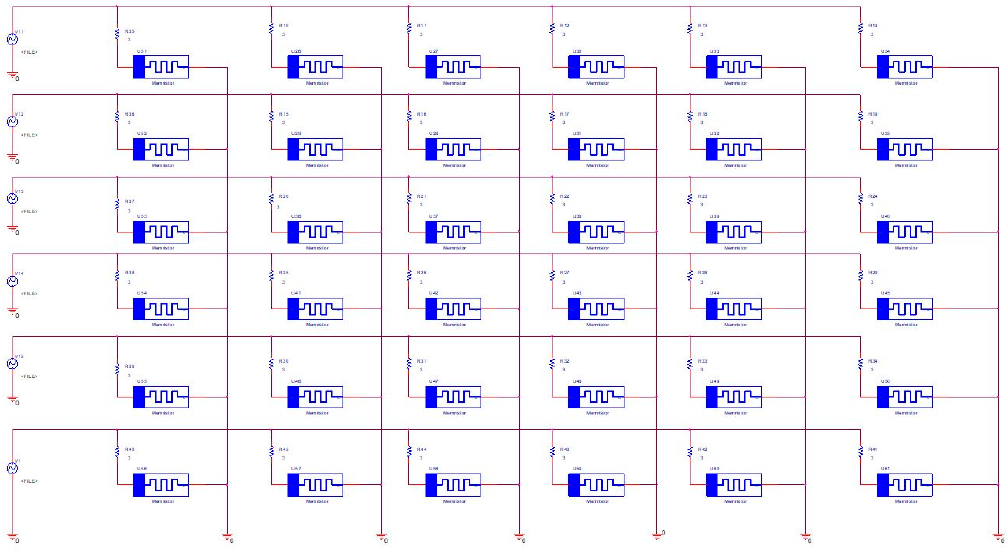
Figure 7. A passive 6 × 6 memristor memory crossbar.